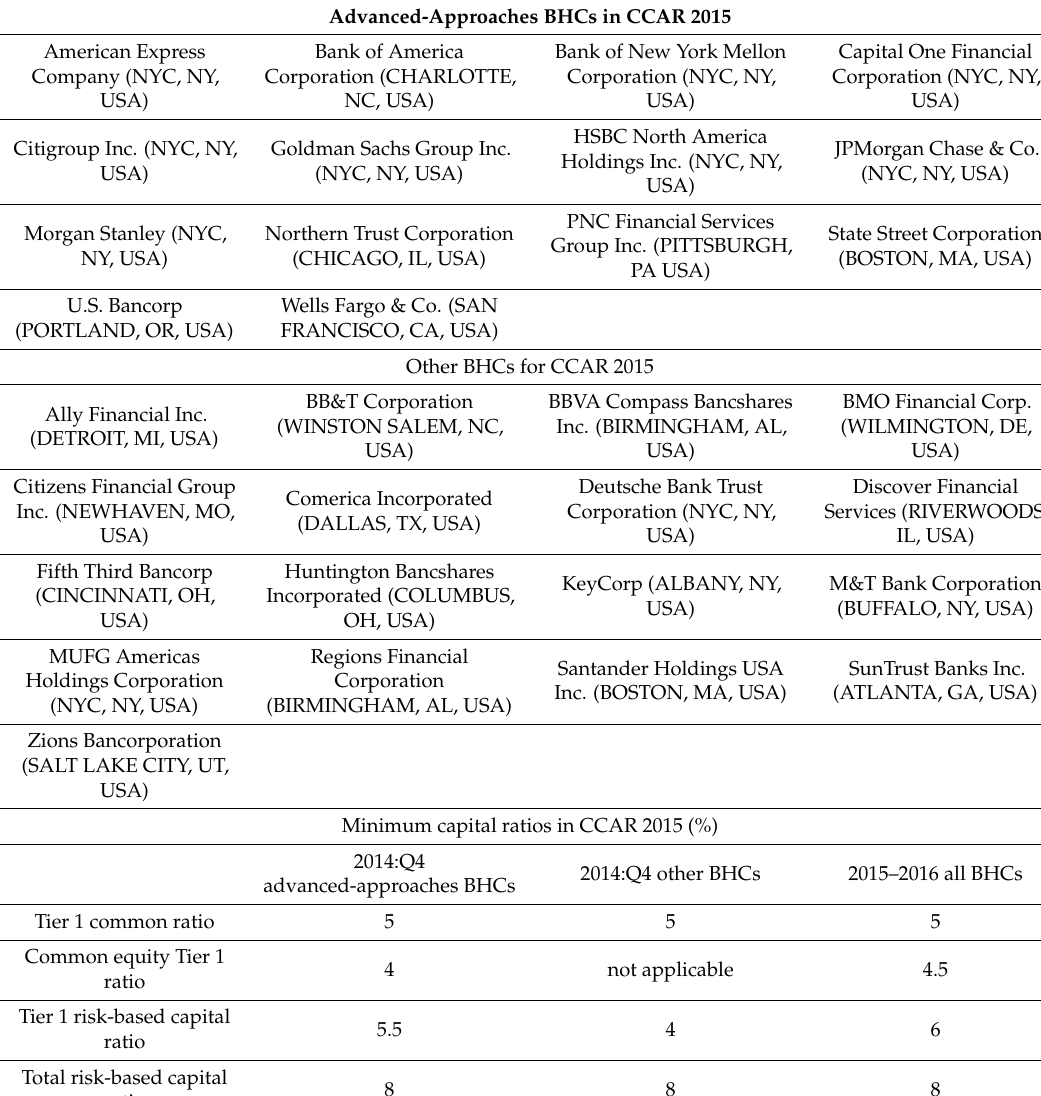
Table 7. Comprehensive Capital Analysis and Review (CCAR) 2015 Bank Holding Companies (BHCs) and Applicable Minimum Capital